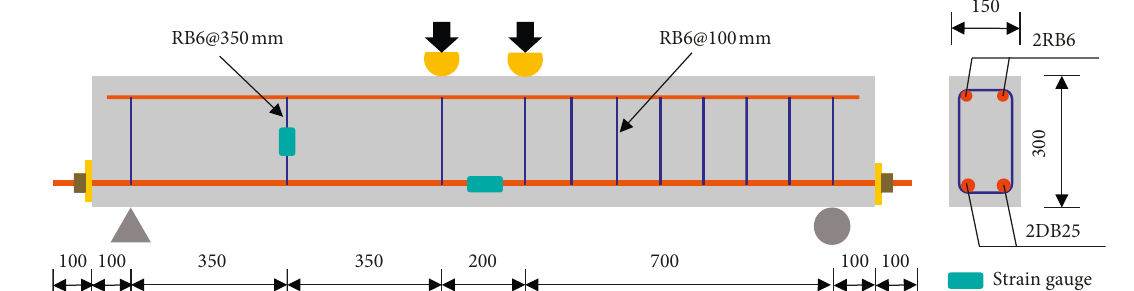
Figure 1: Geometry and reinforcement of RC beams (unit: mm).